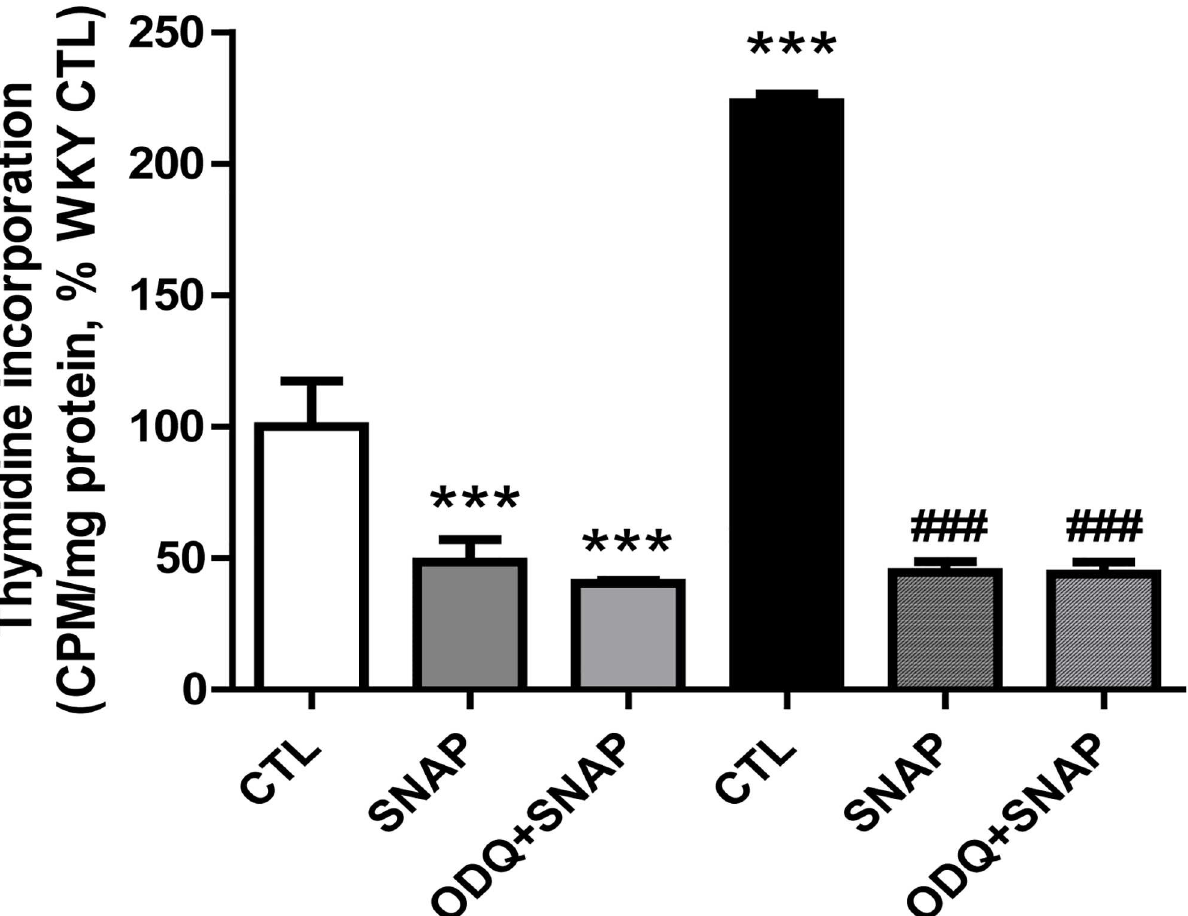
Fig 12. Effect of SNAP on DNA synthesis in VSMC from 12 week-old SHR and age-matchedWKY rats. ConfluentVSMC were incubatedin the absence(control) or presenceof 1H-(1, 2, 4) oxadiazolo [4, 3-a] quinoxalin-1-one (ODQ), for 30 mins prior to the treatment with SNAP for 24 h and thymidineincorporation was determined as describedin Materials and methods. Results are expressedas % of WKY control (CTL), taken as 100%. Valuesare means ± SD of 3 separateexperiments using different cell populations from